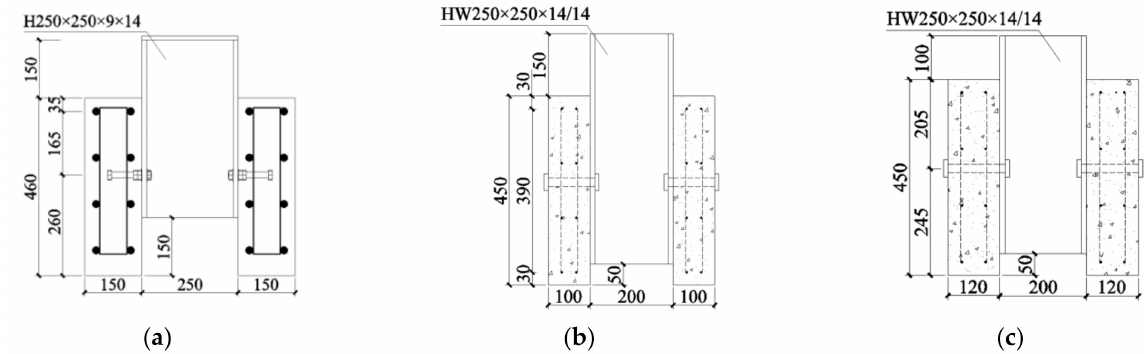
Figure 1. Configuration and details of push-out tested specimens (unit: mm) (Reprinted with